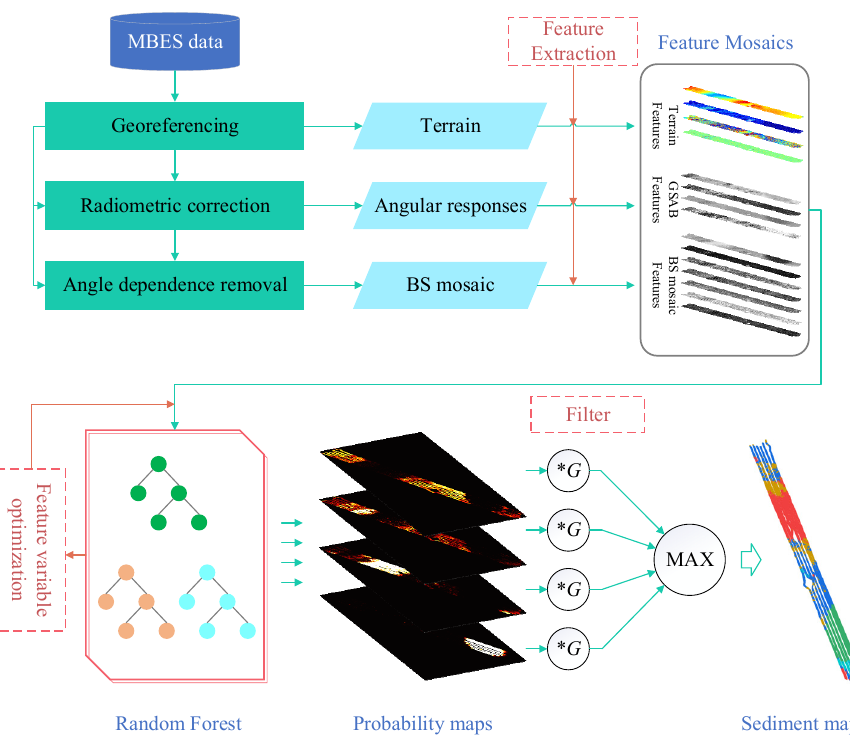
Figure 2. Flowchart of sediment classification based on MBES data. * G indicates the convolution with a Gaussian kernel.